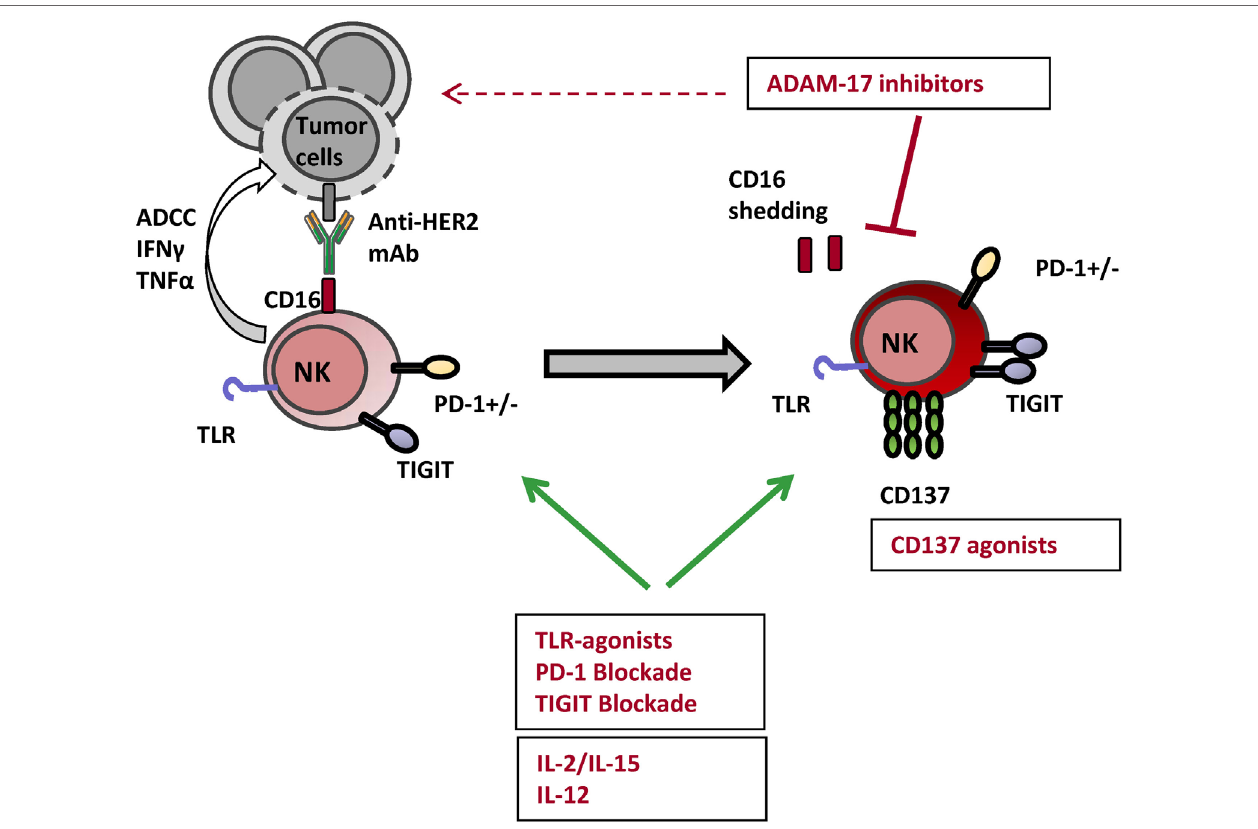
FiGURe 3 | Actionable NK cell checkpoints for enhancing anti-HER2 mAb-induced ADCC responses. Several strategies can be tackled for harnessing NK cell ADCC responses with the objective of enhancing the clinical efficacy of anti-HER2 mAbs. Toll-like receptor (TLR) agonists and cytokines such as IL-2, IL-15, and IL-12 have been shown to lower NK cell activation threshold and enhance their effector potential. Among immune checkpoint modulators targeting surface receptors, anti-TIGIT and anti-PD-1 blocking mAbs as well as anti-CD137 agonist mAbs enhance NK cell-mediated ADCC and survival. Impeding CD16 shedding with A disintegrin and metalloproteinase 17 (ADAM17) inhibitors can be yet another strategy amplifying NK cell-mediated ADCC triggered by HER2-specific therapeutic